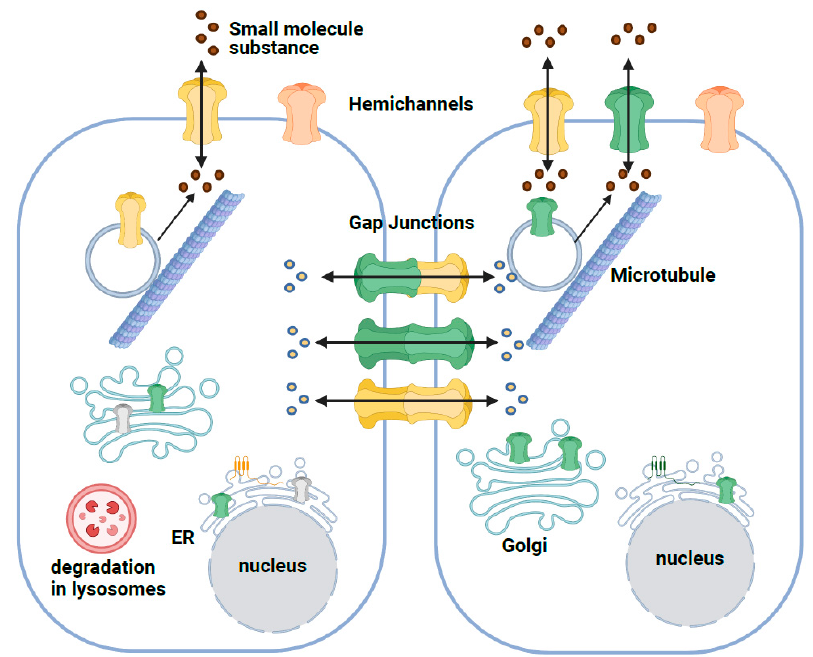
Figure 2. Life cycle of Cx26. Green hemichannels represent Cx26; the hemichannels in other colors represent other connexins. Green gap junction channels represent homotypic gap junction channels composed of Cx26. Yellow gap junction channels represent homotypic gap junction channels com- posed of other connexins. The green and yellow gap junction channels are heterotypic or heteromeric or other types of junction channels composed of Cx26 and other connexins. Cx26 is transcribed in the nucleus and trafficked to the endoplasmic reticulum (ER) for trans- lation into proteins. Hydrolases in lysosomes are mainly used to degrade mistranslated proteins. Wildtype connexins oligomerize in the ER/Golgi. Microtubules assist hemichannels to traffic to the cell surface to allow communication between the cellular cytoplasm and the extracellular space.